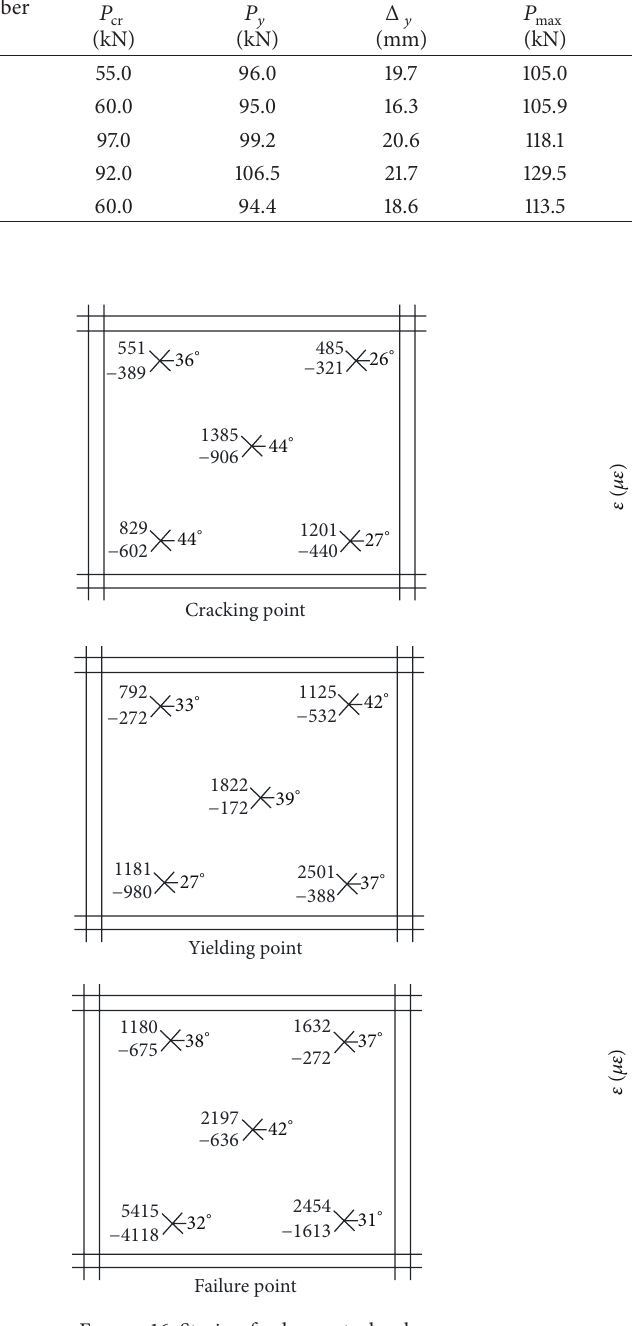
Figure 16: Strain of column steel web.